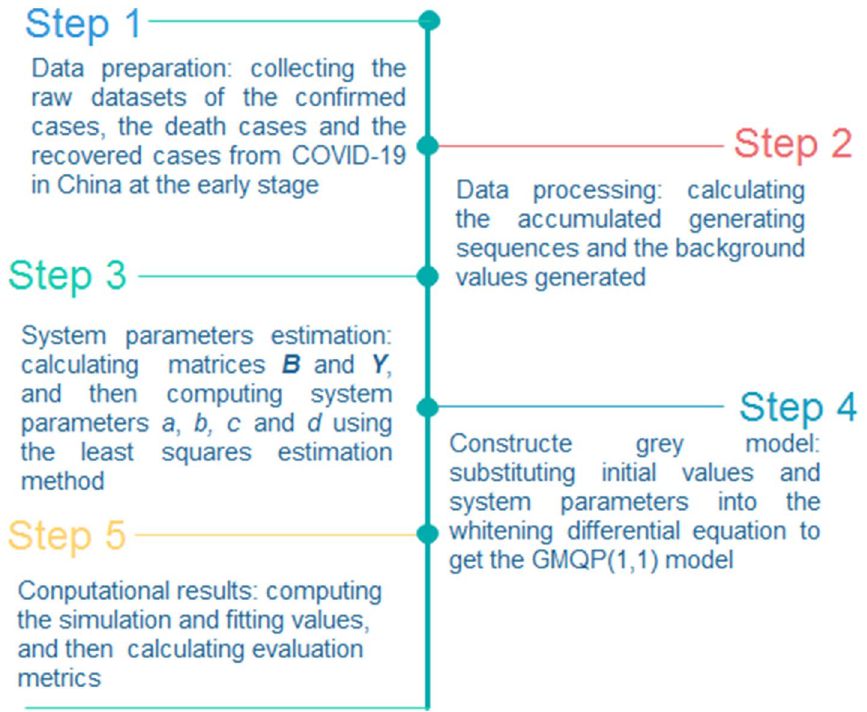
Figure 1. The flowchart of the GMQP(1,1) model.